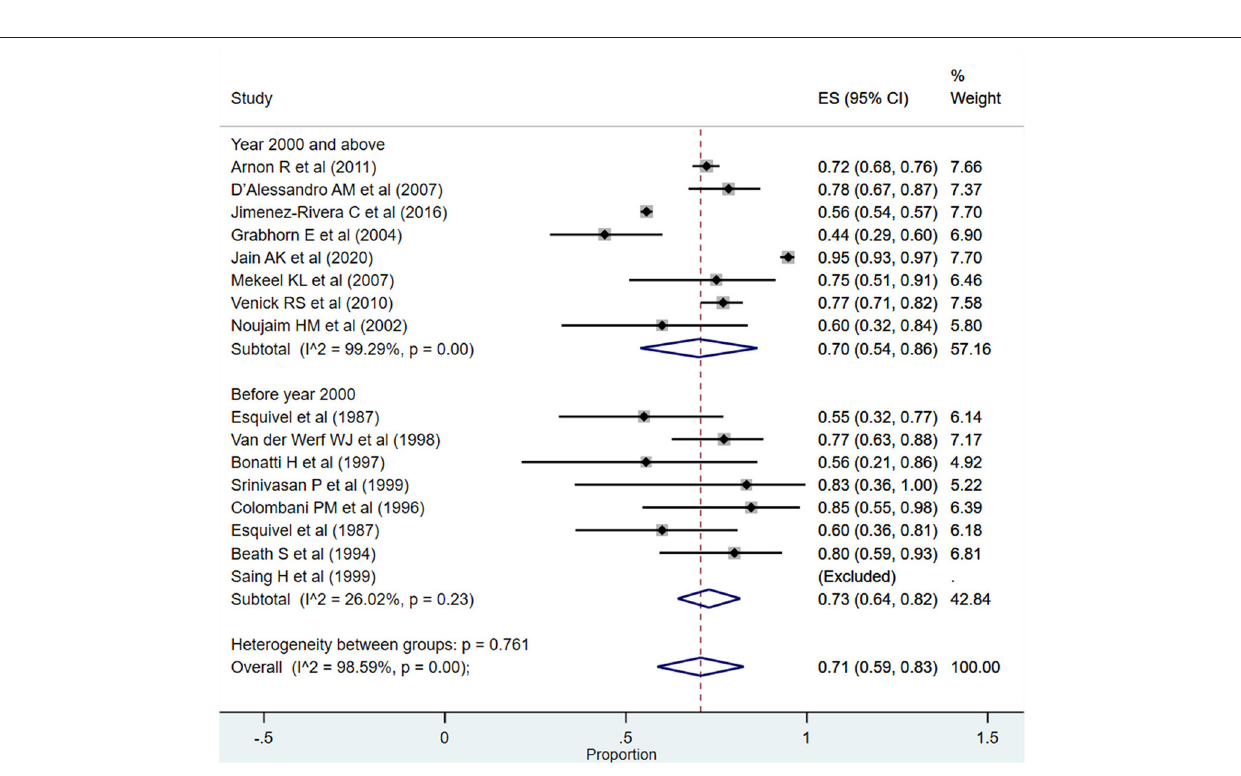
Frontiers in Pediatrics | www.frontiersin.org